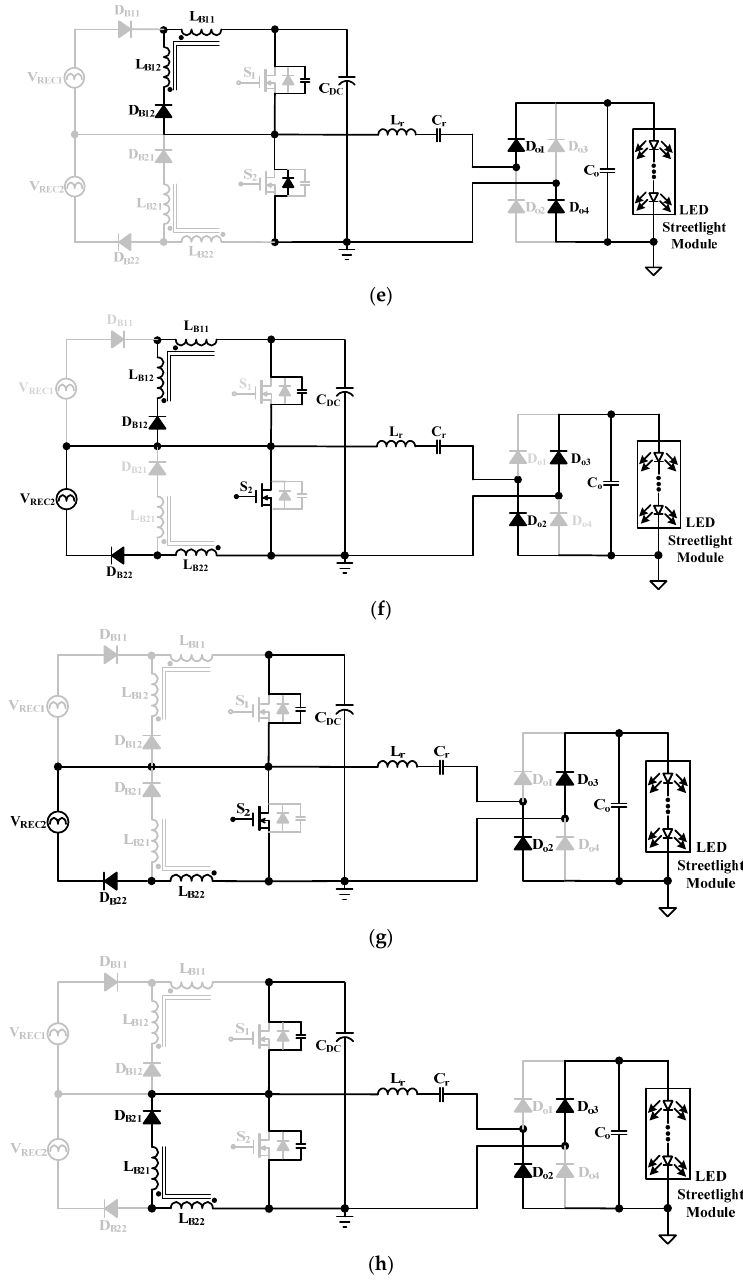
Figure 5. Operation modes of the presented LED driver; ( a ) Model 1; ( b ) Model 2; ( c ) Model 3; ( d ) Model 4; ( e ) Model 5; ( f ) Model 6; ( g ) Model 7; ( h ) Model 8.